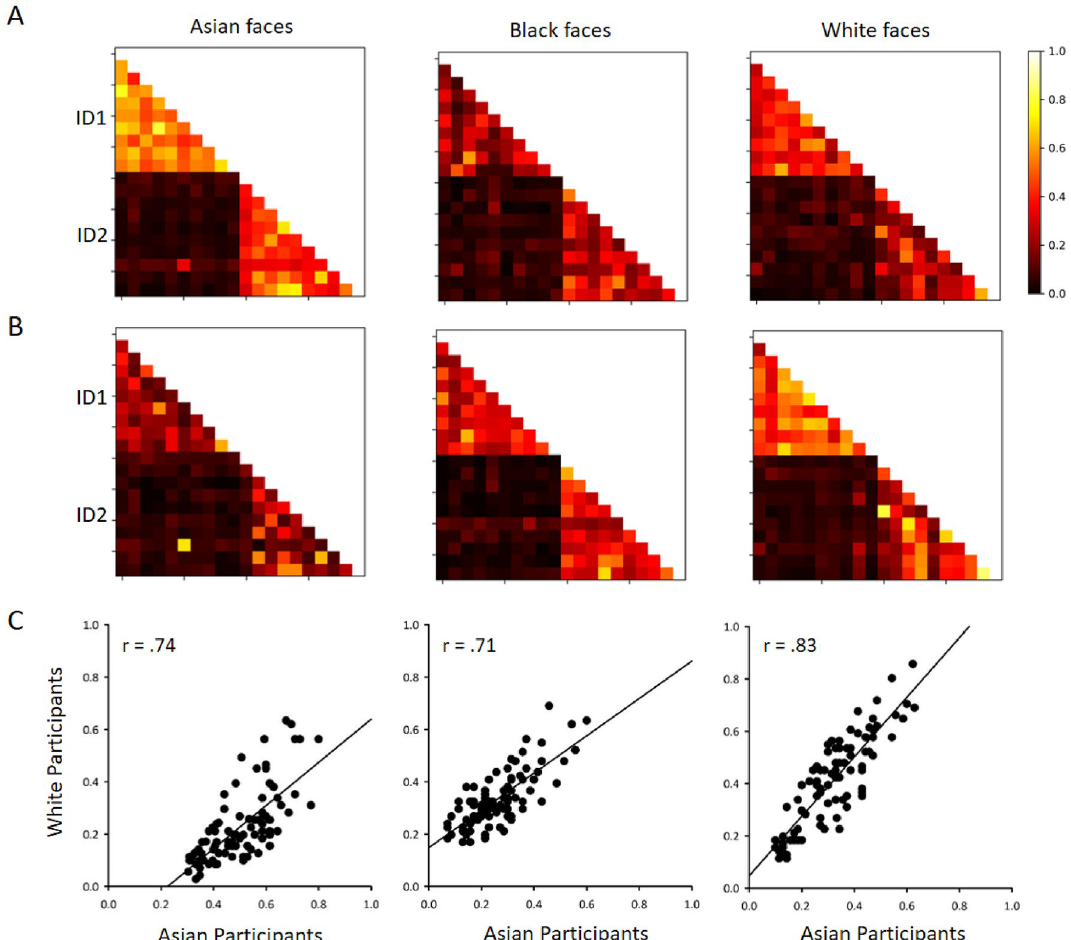
Figure 7. The probability of images being sorted into same pile on each sorting task for ( A ) Asian and ( B ) White participants. ( C ) Correlation of the probability of images being sorted into same pile for within identity images between Asian and White